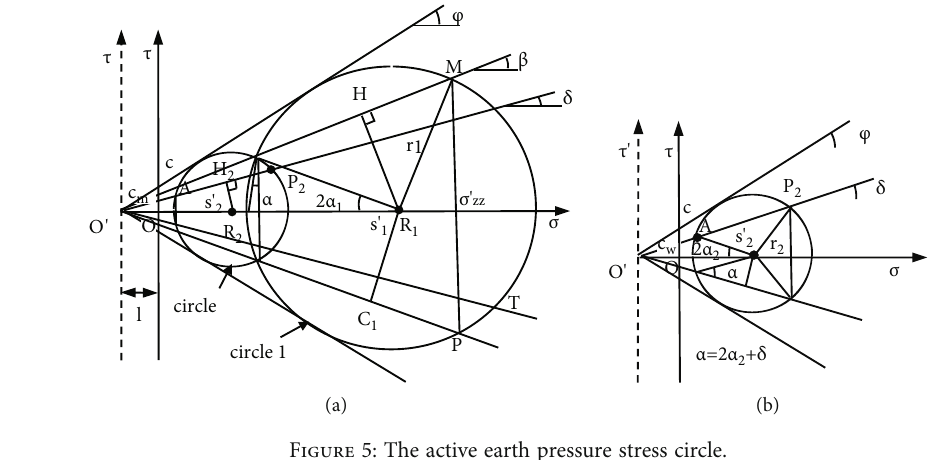
Figure 5: The active earth pressure stress